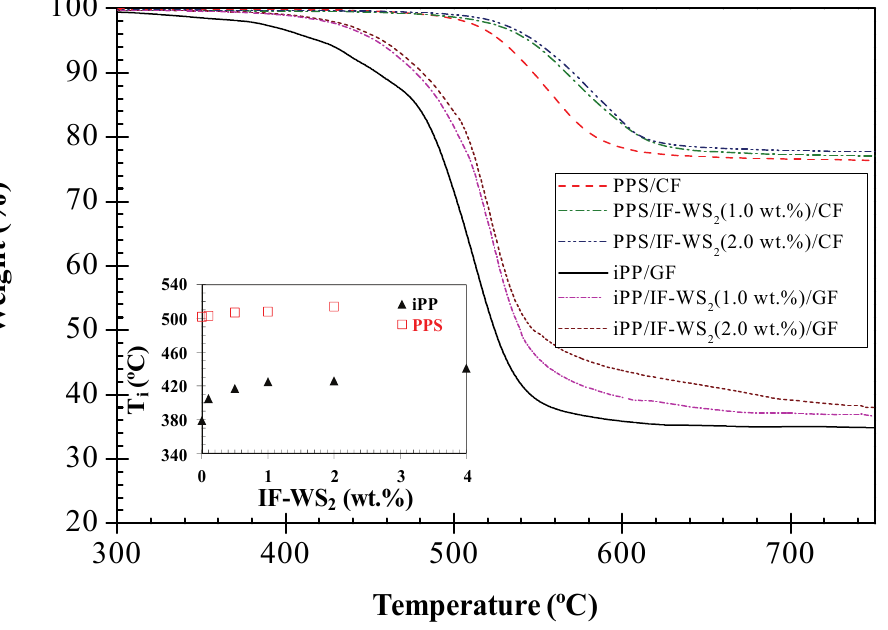
Figure 2. TGA thermograms under a nitrogen atmosphere for neat iPP, PPS and some hierarchical laminates. The inset shows the initial degradation temperature ( T nanoparticle